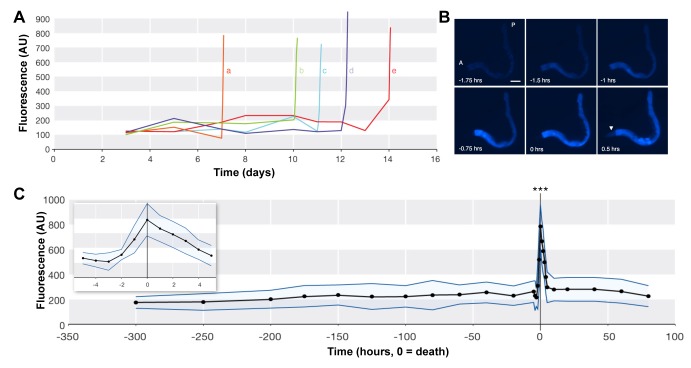
Blue fluorescence increases with death.(A) Fluorescence levels in individual animals (a–e) during life and death. (B) Typical fluorescence change during death from old age. 0 h, cessation of movement (death). All six images are of the same dying animal. Scale bar, 50 µm. (C) Mean levels of fluorescence relative to time of death (black line), ± SD (blue lines). Data from 47 individuals. Inset, death peak detail. AU, arbitrary units.